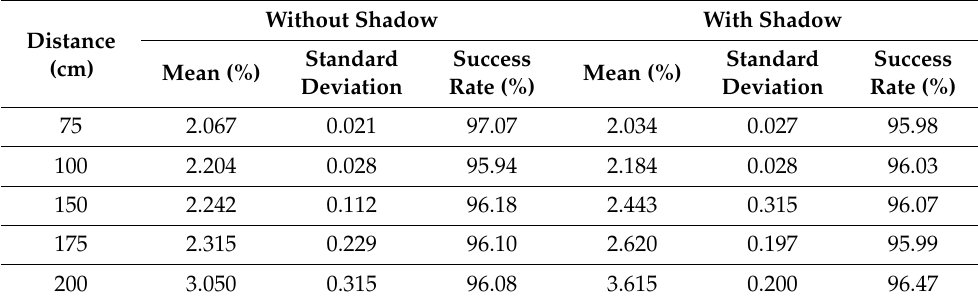
Table 1. ArUco marker pose estimation error (Logitech C270 Webcam) [30].